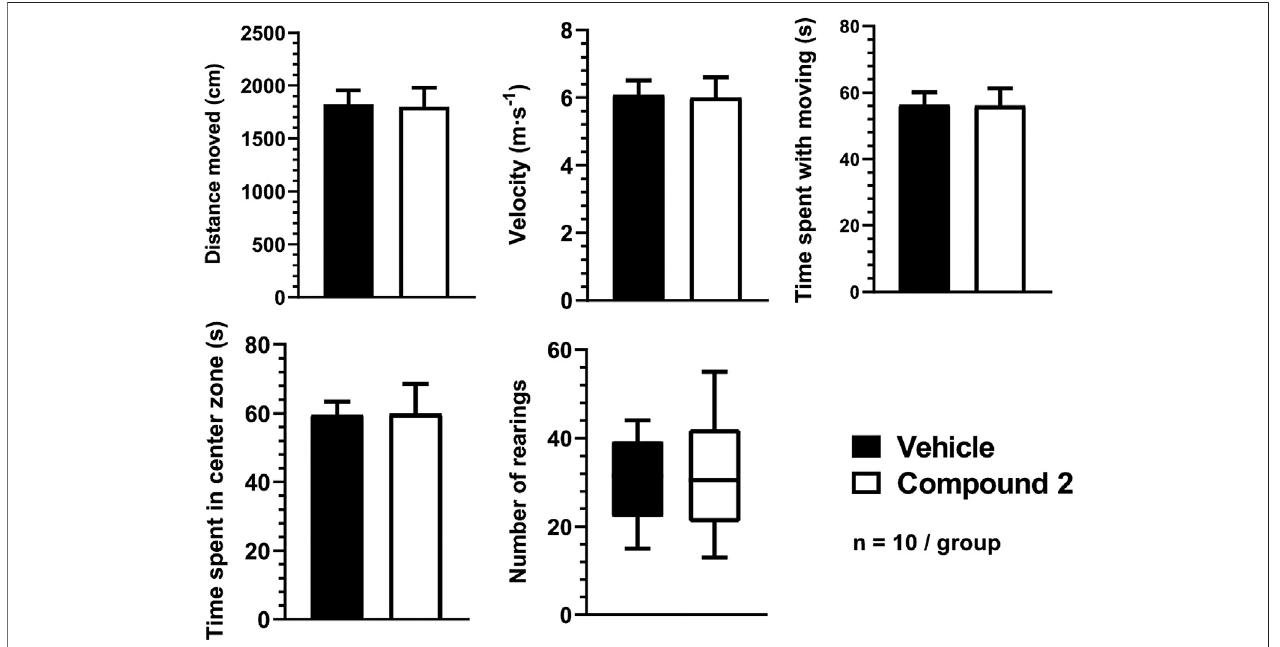
FIGURE7| Spontaneouslocomotor activityand anxiety-likebehaviorquanti fi cationusing OFT.Thenumberofrearings areexpressed asthegeometricmeanwith 95% con fi dence intervals and statistical comparisons were made using the Mann-Whitney U-test. All other data are determined as mean ± S.E.M. and were compared using the Student ’ s unpaired t-test, n (cid:2)